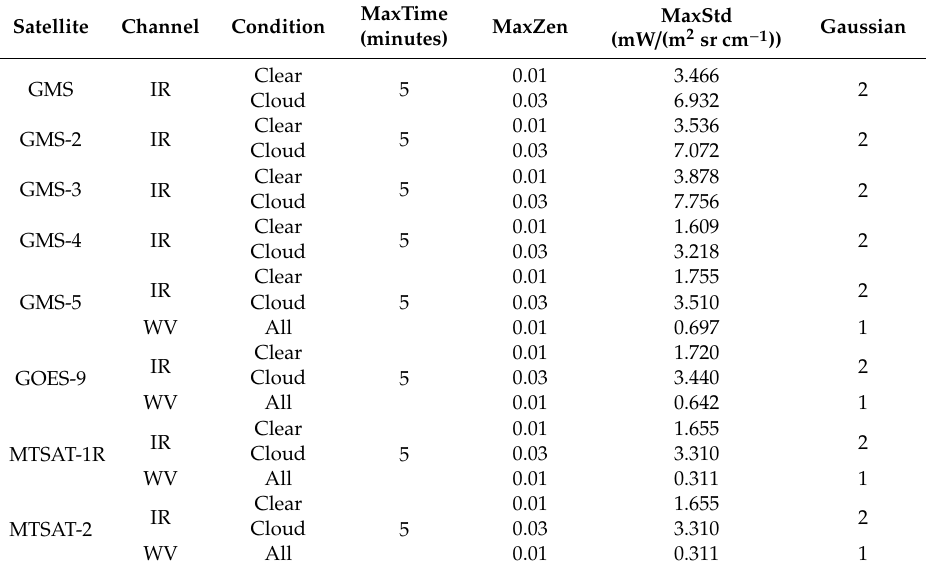
Table 4. Collocation conditions for JMA’s GEO satellites.